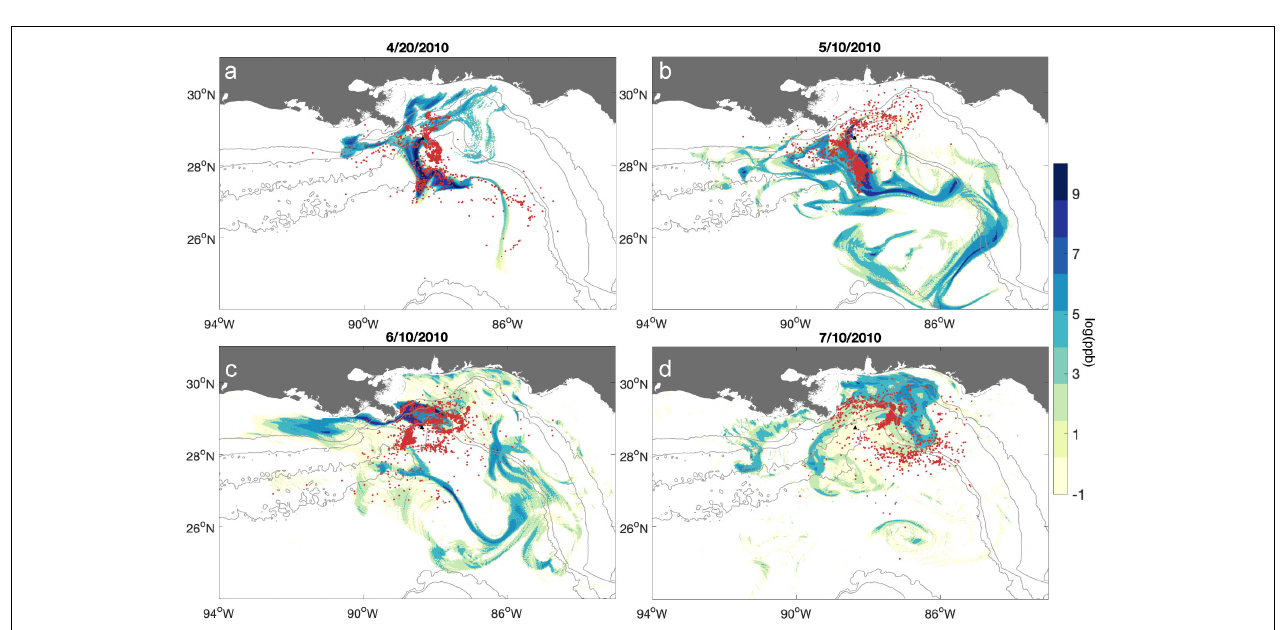
FIGURE 1 | Median (line) and median absolute deviation (mad, blue shaded area) of solar irradiance (Wm − 2 ) at the sea surface during daylight hours (7am to 7pm CST) over the area adjacent to the Macondo well and DWH response site (27 ◦ N to 30 ◦ N; 90 ◦ W to 86 ◦ W) in the Gulf of Mexico. Three-hourly shortwave solar irradiance values for the region were obtained from the 2010 NOGAPS model. Dates show significant events for response to the DWH oil spill, including the onset of SSDI (April 30th), top hat (May 13th), riser cut followed by the Lower Marine Riser Package (June 4th), and the period Hurricane Alex was present in the Gulf of Mexico (June 24th to July 2nd).